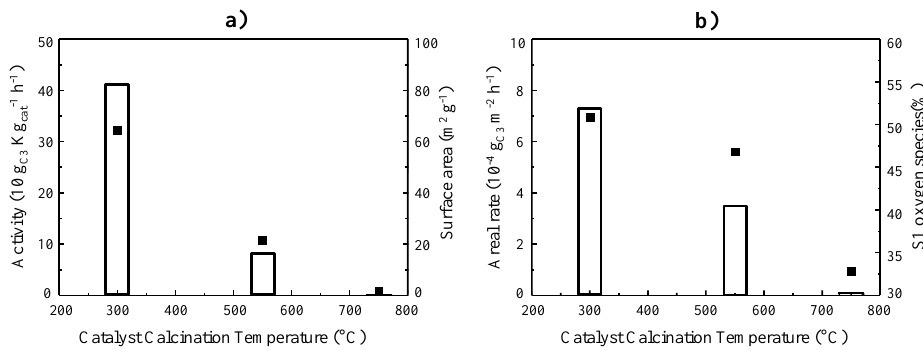
Figure 8. Variations in the catalytic activity per mass unit (white bars) and the BET surface area (black squares) ( a ) and variations in the areal rate (white bars) and the amount of S1 oxygen species at the near surface (black squares) ( b ) with the calcination catalysts for Co300, Co550, and Co750 catalysts. Reaction temperature = 190 °C; remaining conditions provided in the text.